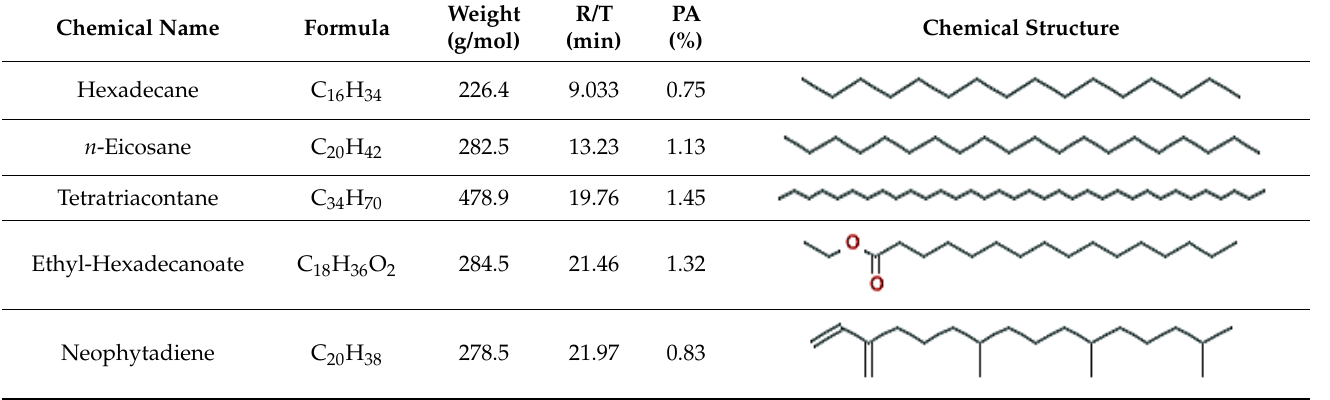
Table 1. Chemical characterization of NH-EDx ( n -Hexane extracts of E. divaricate ). R/T: retention time; PA: peak area.